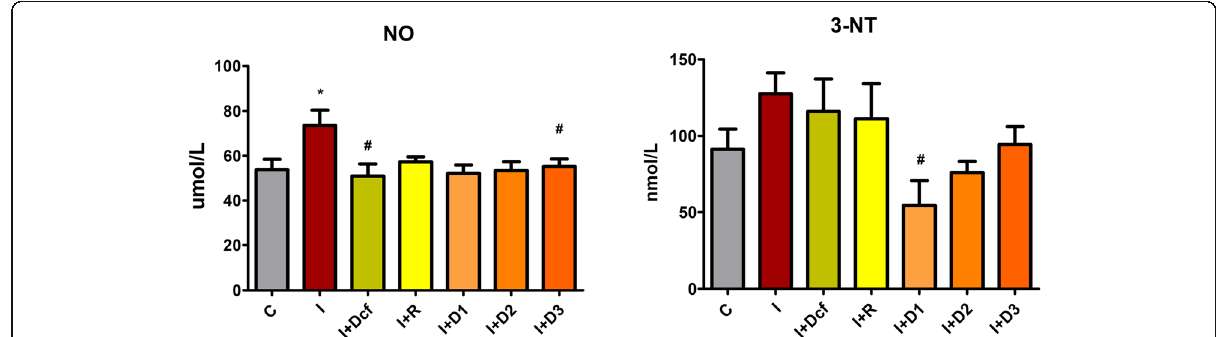
Fig. 5 In vivo anti-inflammatory effects of H. capitatum extract on NO and 3-NT levels in serum . Data represent mean ± SEM; One-way ANOVA followed by Bonferroni ’ s Multiple comparison test; * Significant at p < 0.05; **Significant at p < 0.01; ***Significant at p < 0.00 – compared with C group; # Significant at p < 0.05; ## Significant at p < 0.01; Significant at p < 0.00 – compared with I group; [C- Control; I- Inflammation; Dcf- Diclofenac; I + R- Inflammation + Rutin; I + D1 – Inflammation+ Dose 1 of H. capitatum extract; I + D2 - Inflammation + Dose 2 of H. capitatum extract; I + D3 - Inflammation + Dose 3 of H. capitatum